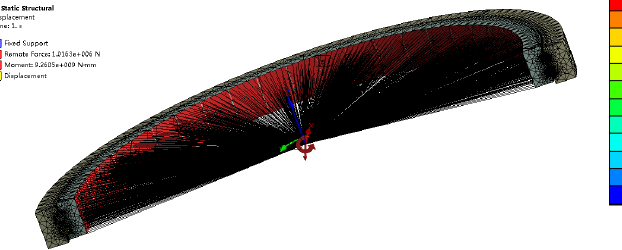
Figure 16: Finite element model of slewing bearing